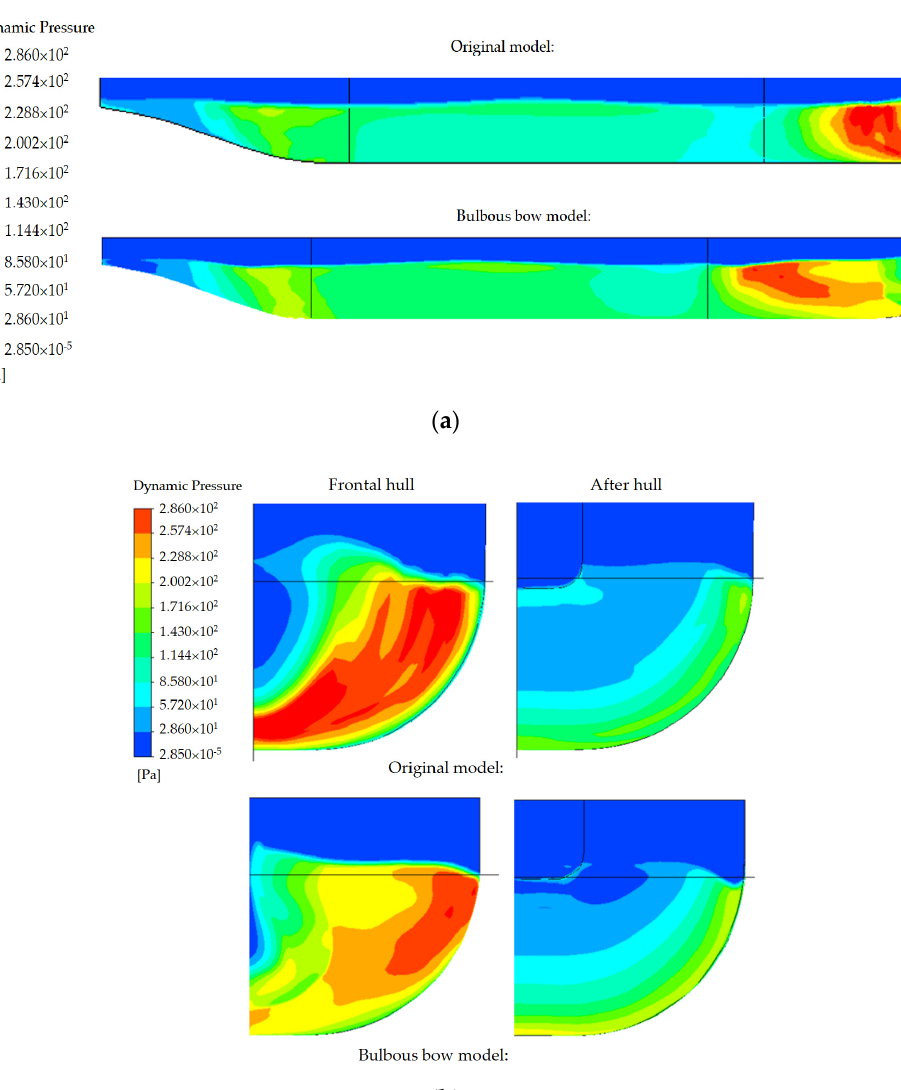
Figure 10. Simulated dynamic pressure distribution over the surface of the ship’s hulls in regular head and short waves, H w = 0.02 m and the ratio λ /L pp = 0.4, at F n = 0.163. ( a ) Side view; ( b ) frontal and aft view.